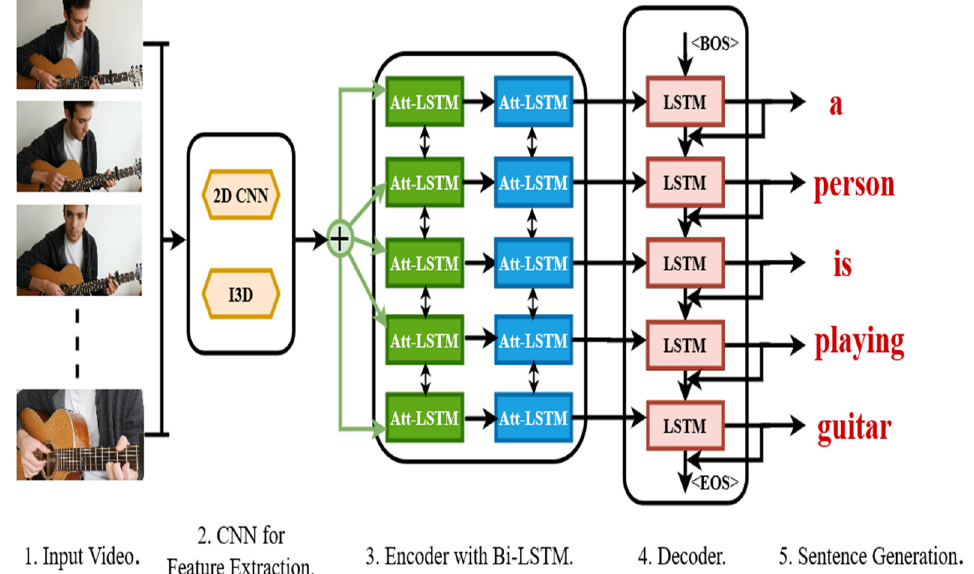
Figure 1. A comprehensive framework of our proposed video description generation model. Here, ( 1 ) the input of the model is video. ( 2 ) 2D and I3D CNN are used for feature extraction from the input visual frames. ( 3 ) The model contains attention-based bi-directional LSTM as an encoder. ( 4 ) A forward pass LSTM is used for sequential sentence generation. ( 5 ) Lastly, the sentence generation module is used for captioning the video.